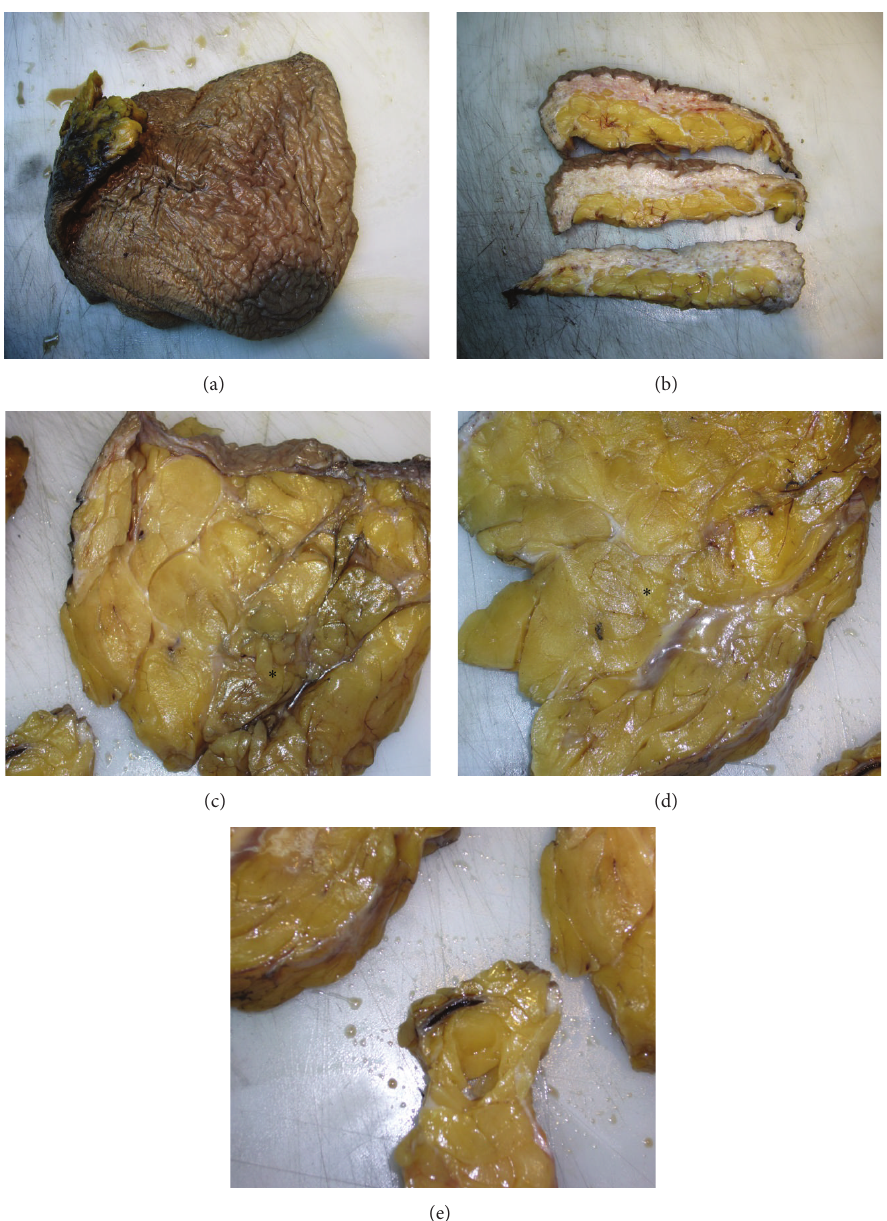
Figure 1: Macroscopic characteristics of MLL. The skin is indurated and hyperpigmented with classical “peau d’orange” appearance (a). The cut surface revealed the thickened skin (b). The subcutaneous tissue cut surface showed serous fluid (indicated by “ ∗ ”) and also lobulated proliferation of fatty tissue (c) partially surround by thickened fibrous bands ((d), indicated by “ ∗ ”). Focal dilated, thrombotised vessels were also noted